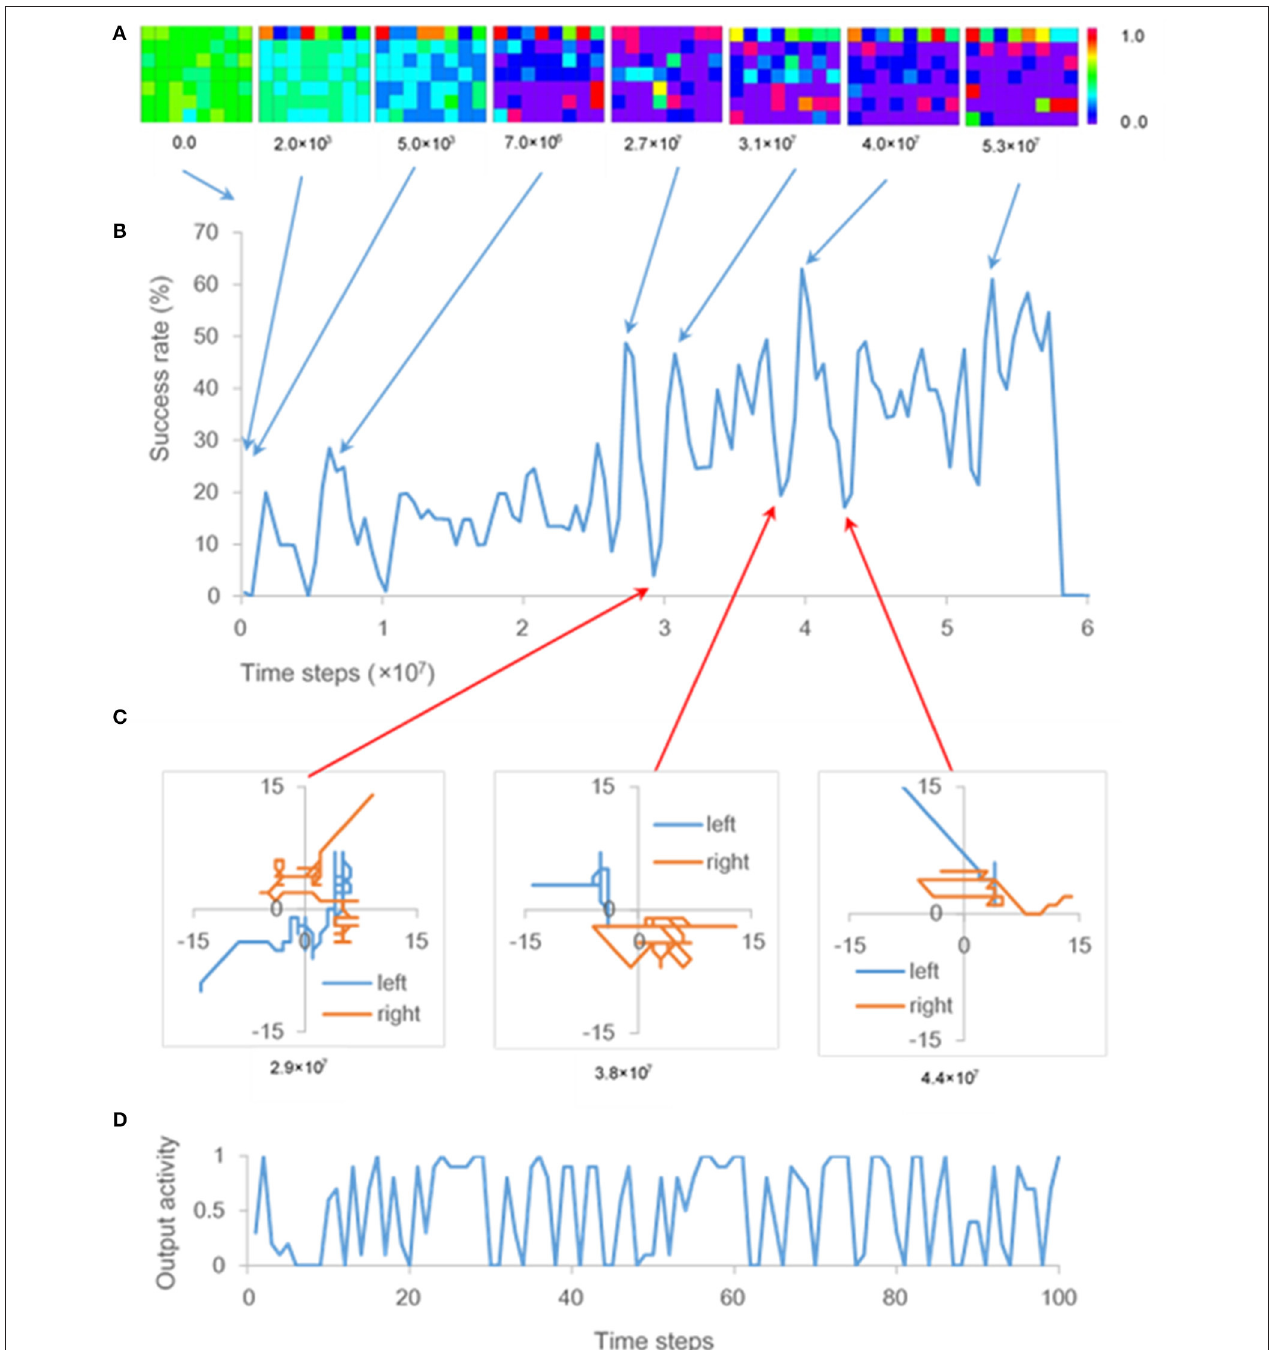
FIGURE 3 | Output activity and success rate. (A) Output activities resulting from one of ten training times. Each panel represents output activities of the hidden and output units at 0.0, 2.0 × 10 3 , 5.0 × 10 3 , 7.0 × 10 6 , 2.7 × 10 7 , 3.1 × 10 7 , and 5.3 × 10 7 time steps. Squares of the top line, those of lines 2–4, and those of lines 5–7 of each panel are output activities of the eight output units, 24 hidden units related to sense of ownership, and 24 hidden units related to sense of agency, respectively. (B) One of the time series of success rate, as described in section Cell Assemblies Appearing During the Phase of U-shaped Development, obtained by ten-times training. (C) Trajectories of both “hands” during a 100-time-step period at 2.9 × 10 7 time steps, 3.8 × 10 7 time steps, and 4.4 × 10 7 time steps. (D) Time series of output activity corresponding to one of the hidden units during a 100-time-step period at 2.9 × 10 7 time steps, when movements like GMs occurred (C) .